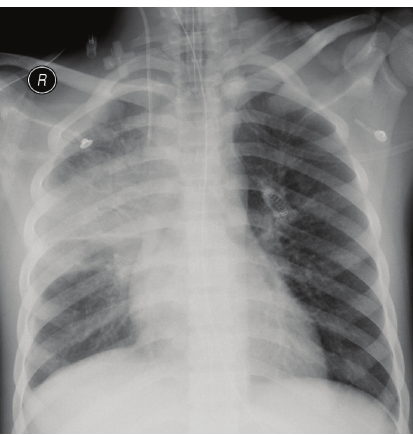
Figure 1: Chest radiograph showing a right mid zone consolidation and a slightly blunt right costophrenic angle.